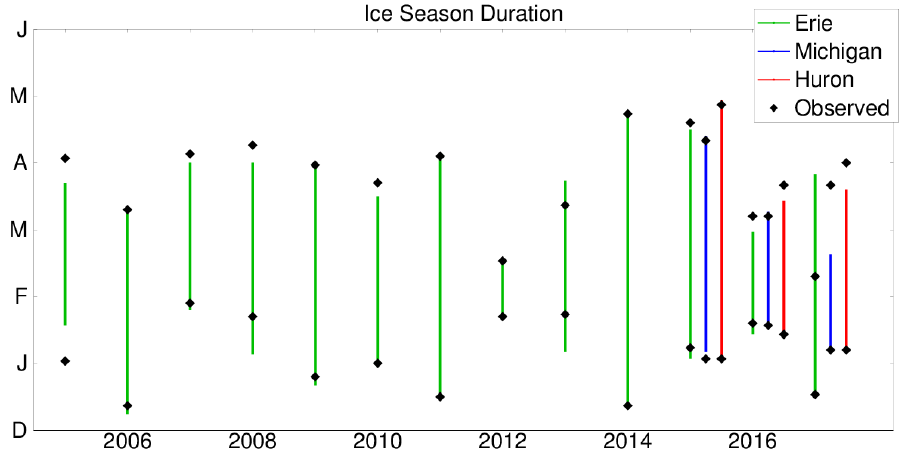
Figure 9. Ranges of spatial concentration RMSE as functions of month ( a ), ice concentration ( b ) and ice thickness ( c ) for Lake Huron from the LMHOFS 2015-2017 simulation results. See the caption of Fig. 5 for the explanation of the box, whiskers, and solid circles. For ( c ), open water cells are excluded.